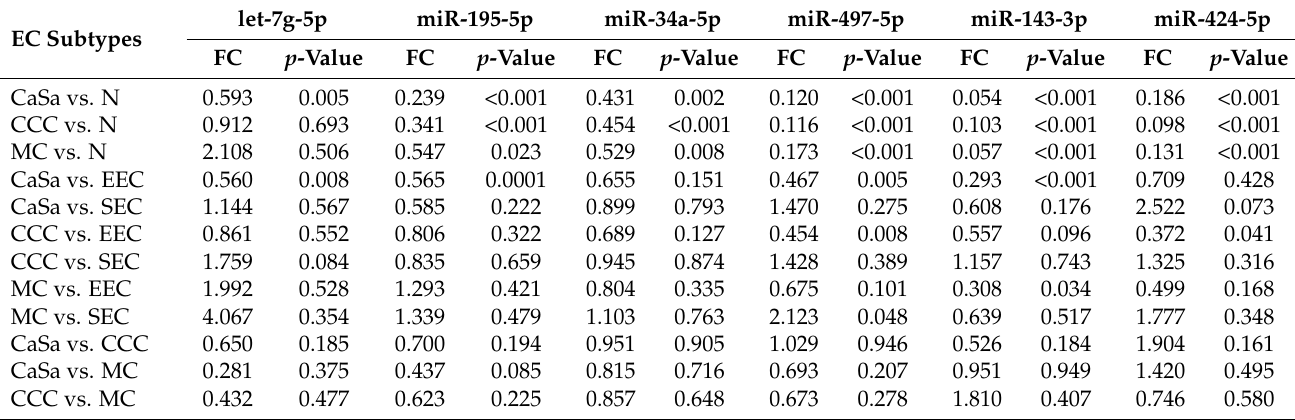
Table 3. Rare subtypes of endometrial carcinoma: expression of miRNAs selected for discrimination of endometrioid and serous subtypes.